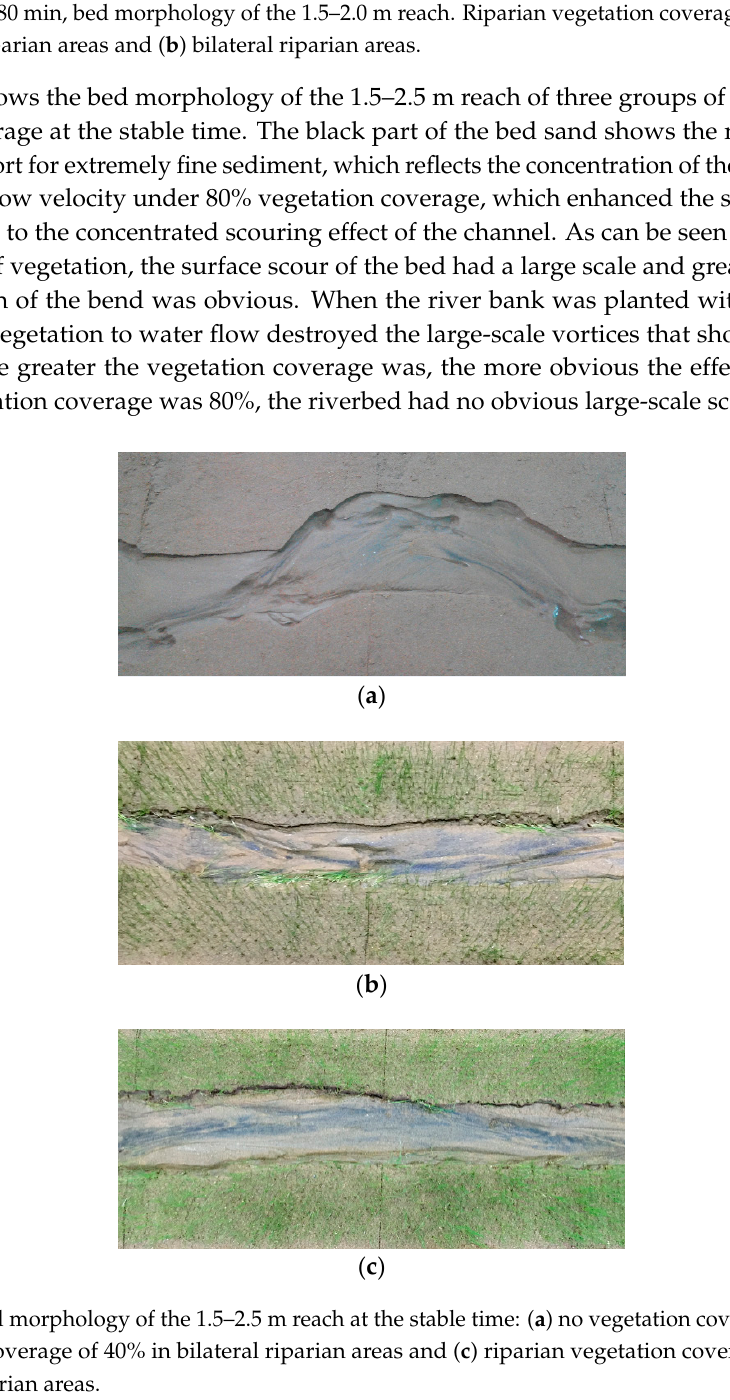
Figure 7. At 80 min, bed morphology of the 1.5–2.0 m reach. Riparian vegetation coverage of 40% in ( a ) unilateral riparian areas and ( b ) bilateral riparian areas.